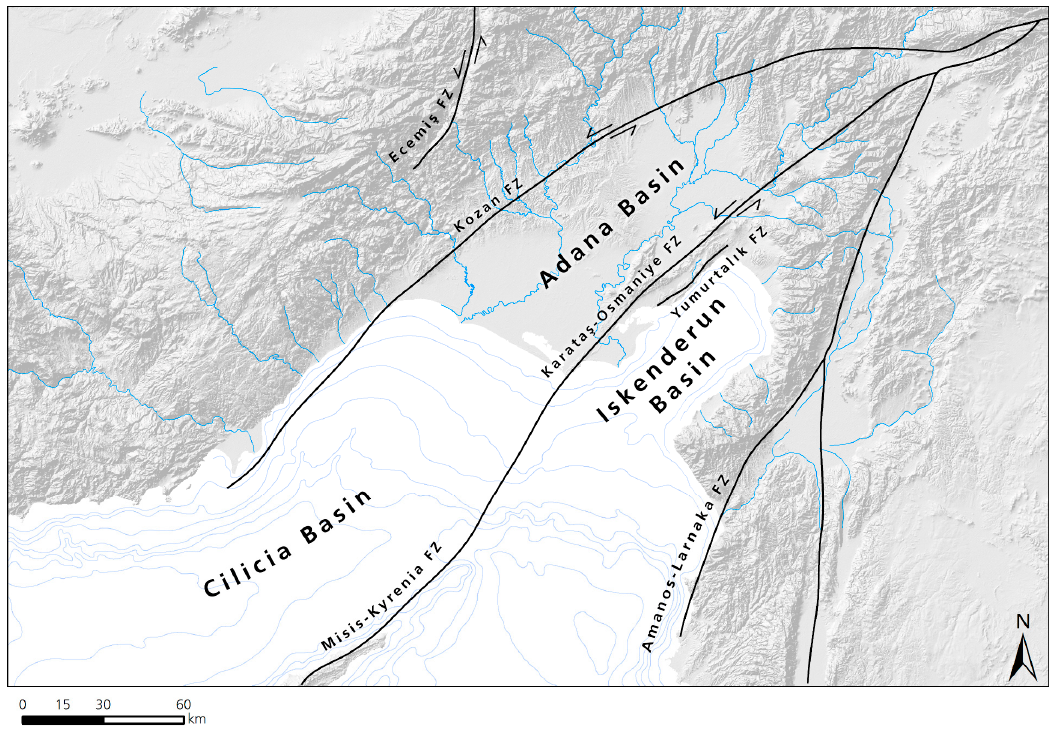
Figure 2. Morphological and simplified tectonic map of the region with the locations of major Neogene basins and the main fault zones (FZ) (after [19] Figure 1), © Susanne Rutishauser.